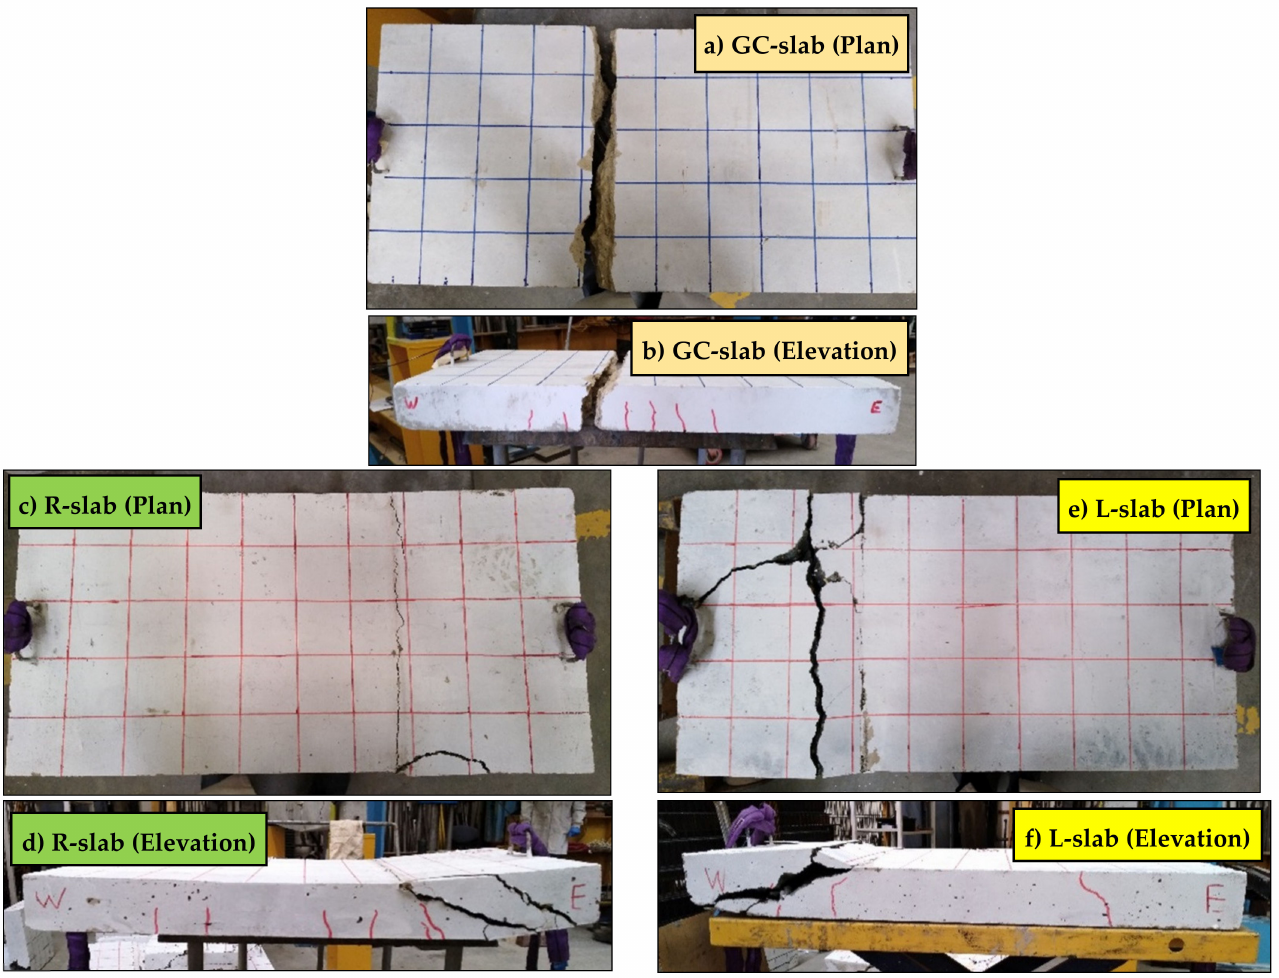
Figure 13. Global damage, crack extension, and failure mode of the tested slab specimens: CC-slab in ( a , b ), R-slab in ( c , d ), and L-slab in ( e , f